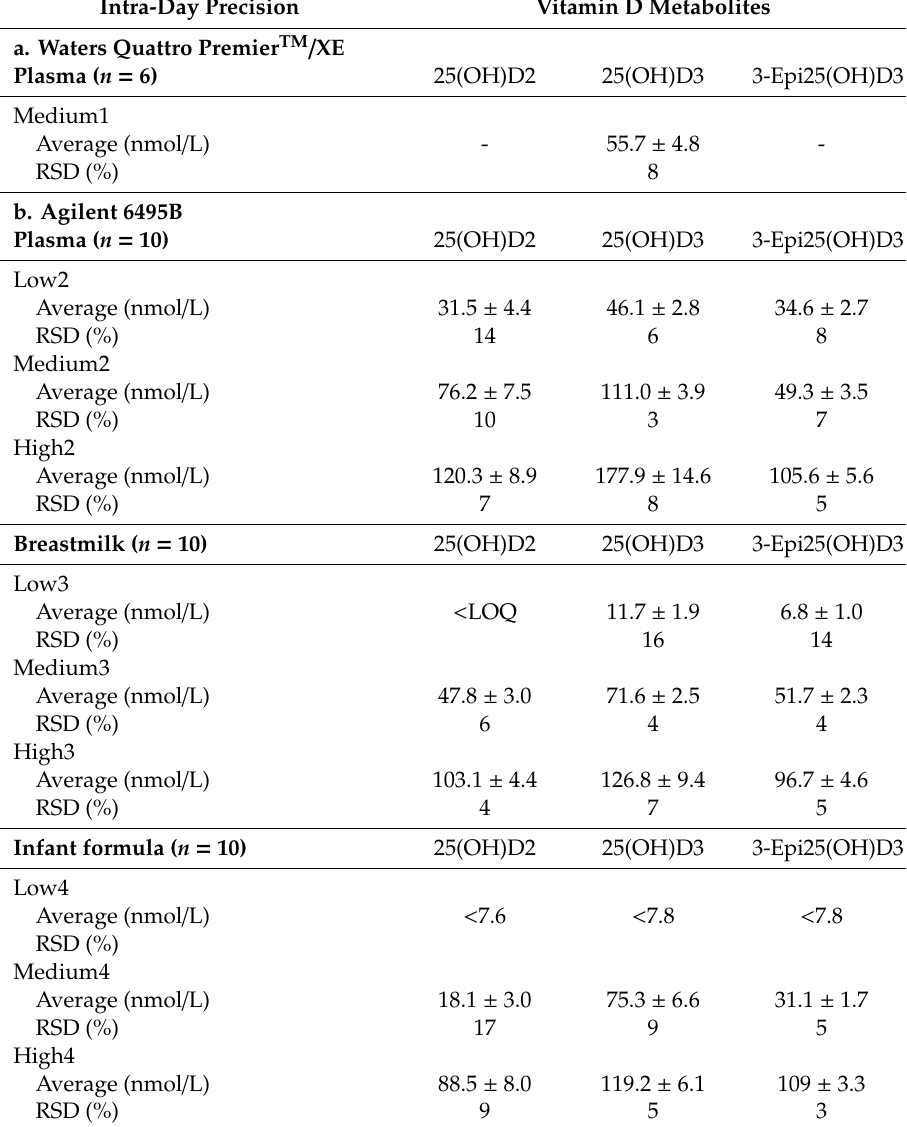
Table 2. Intra-day ( n ) of vitamin D metabolites in plasma, breastmilk, and infant formula